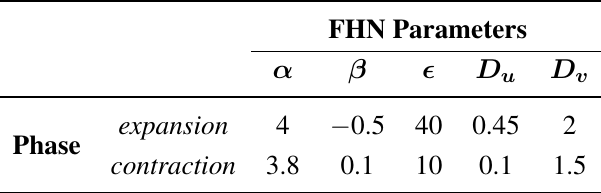
Table 1. Set of values for the FHN model to reproduce the desired behavior in both phases: expansion and